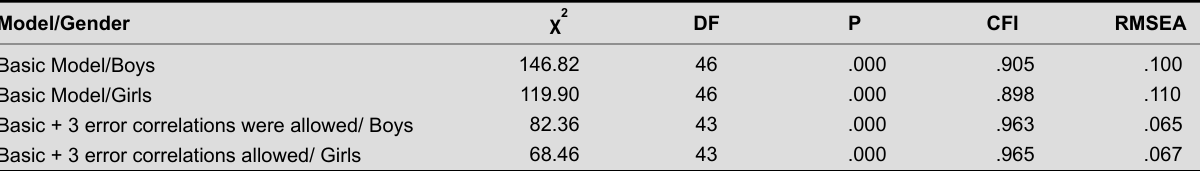
Fit Indices of The Basic Model for Each Gender